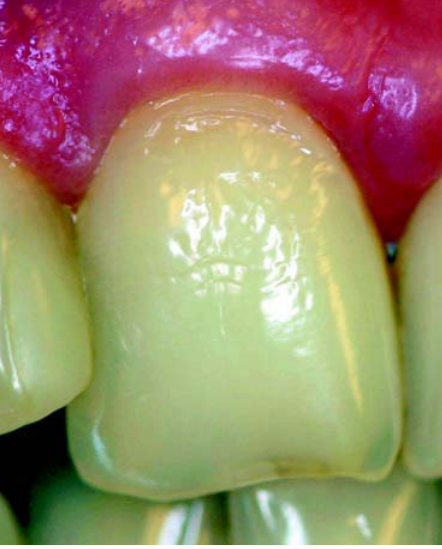
FIGURE 1- Clinical appearance of tooth wear in enamel.